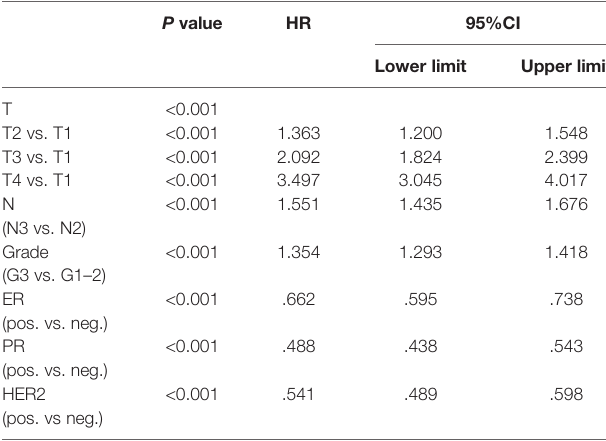
TABLE 2 | Multivariate survival analysis by Cox proportional hazard regression modeling in TxN2-3M0 breast cancer patients. P